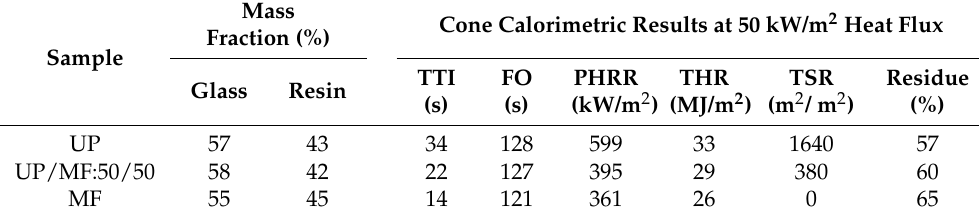
Table 7. Composition and flammability results of GFRC composites of UP, MF, and UP/MF: 50/50 blend. Mass Fraction (%) Sample Resin